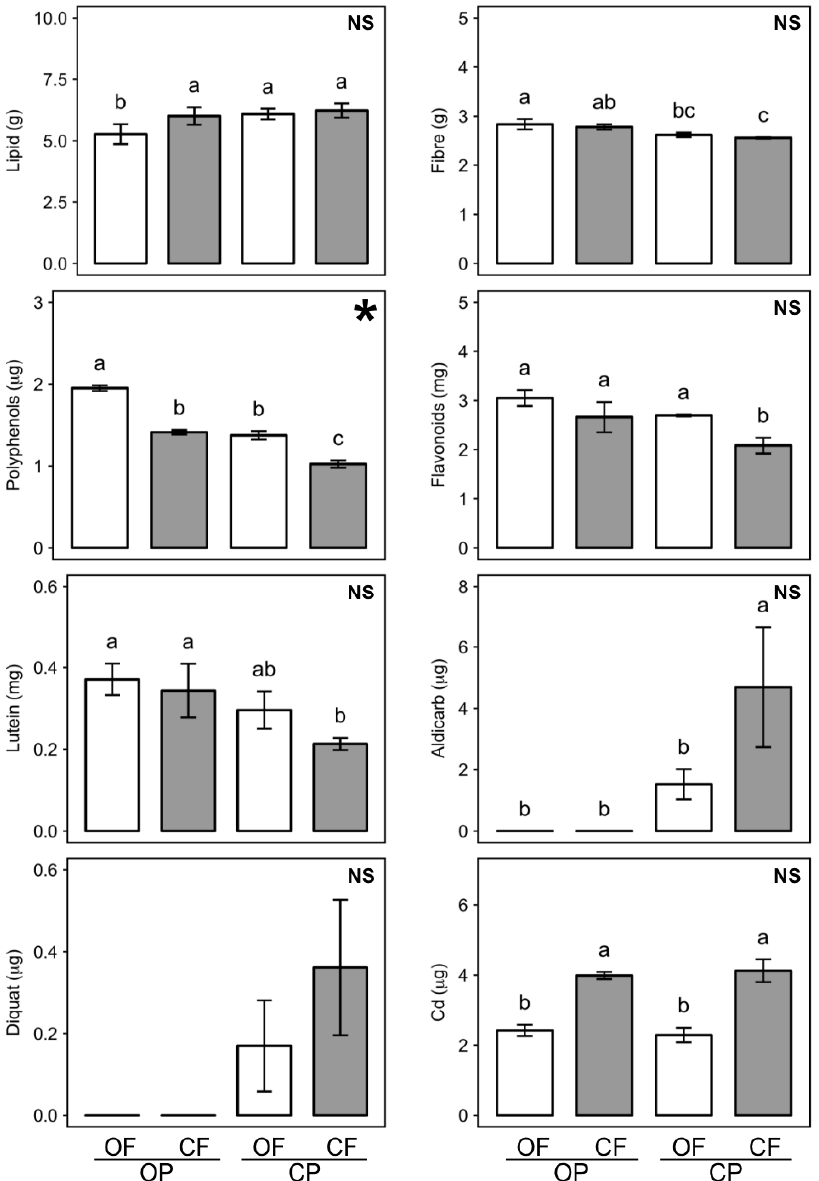
Figure 1. Effects of organic crop protection (OP) or conventional crop protection (CP) and organic fertility management (OF, white bars) or conventional fertility management (CF, shaded bars) on the lipid, fiber, polyphenols, flavonoids, lutein, aldicarb, diquat and cadmium content (per 100 g fresh weight) in experimental feeds. Results shown as means ± SEM of n = 4 field replicates, different letters above bars indicate significant difference ( p < 0.05) determined by Tukey’s HSD test. * two-factor ANOVA detected a significant interaction between crop protection and fertilization regimes (see Table S3).